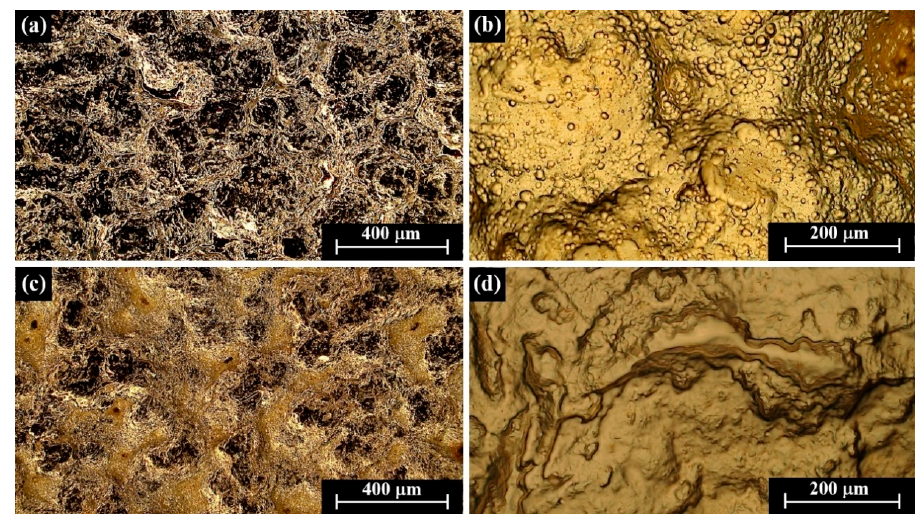
Figure 11. Multi-focal optical light microscope (LM) images of the AM-LPBF AlSi10Mg disk-shaped specimens: ( a , b ) la- boratory-developed Au coating; and ( c , d ) commercial Au